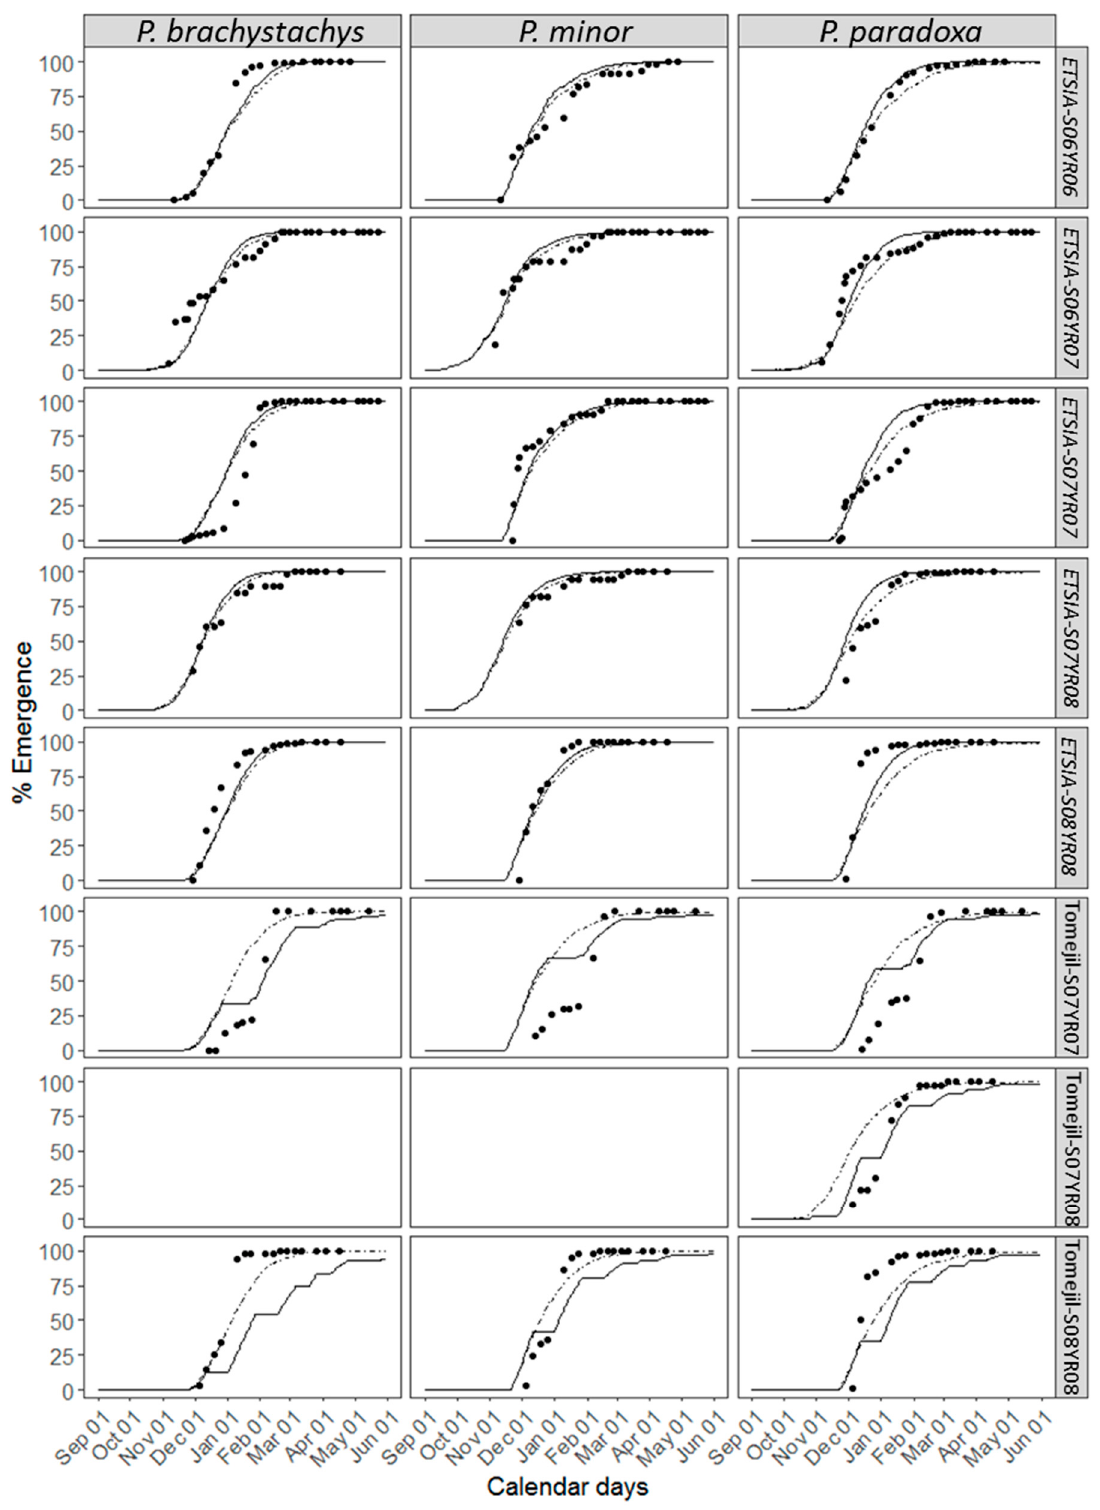
Figure 3. Predicted emergence for the three Phalaris species, using thermal (dotted line) and hydrothermal (black line) time ‐ based Weibull models at each location and for the first and second seasons in each plot. Black dots—observed (mean) seedling emergence. Scarce seedling emergence did not allow fitting the models to the data in P. brachystachys and P. minor at Tomejil ‐ S07YR08.